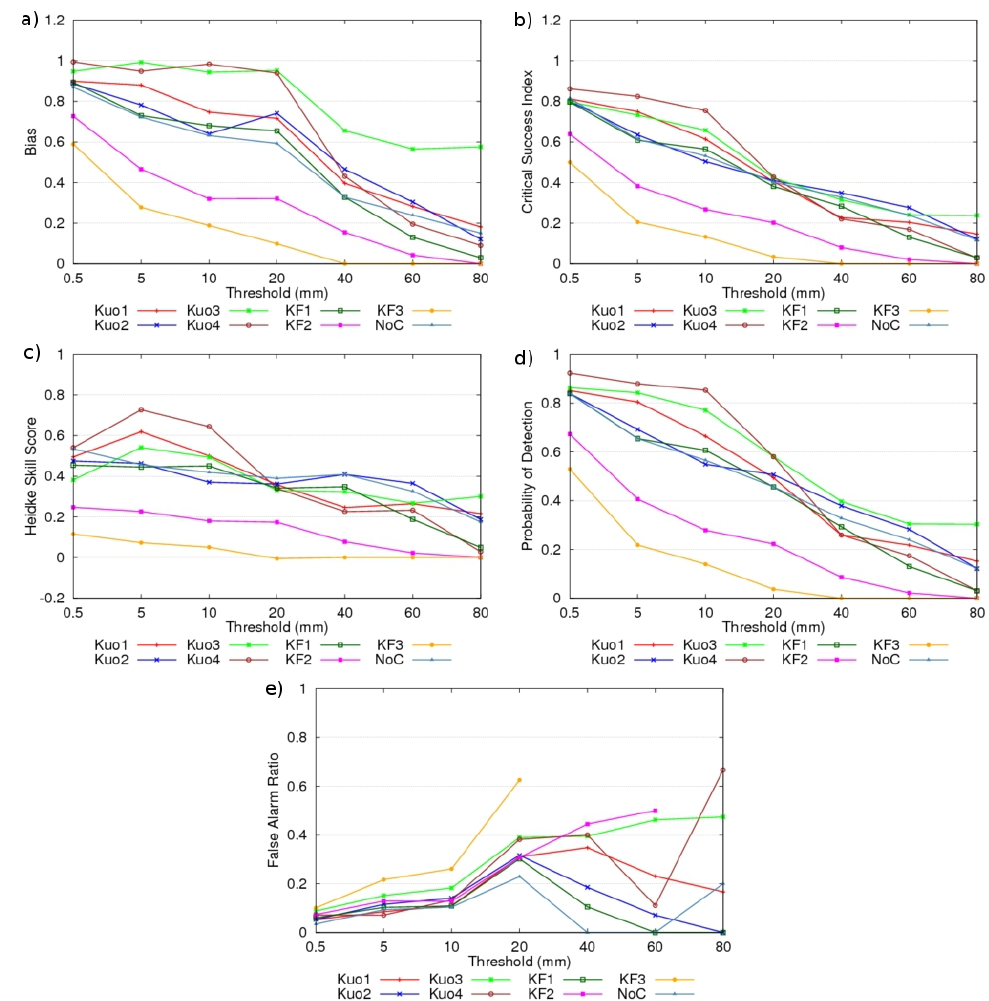
Fig. 13. RAMS skill scores: (a) Areal Bias, (b) Critical Success Index, (c) Heidke Skill Score, (d) Probability of Detection and (e) False Alarm